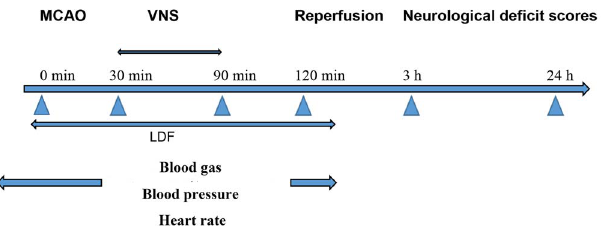
Figure 1. The Experimental Protocol. I/R and I/R + VNS groups underwent transient MCAO surgery. In the I/R + VNS and sham + VNS group, VNS was initiated at 30 min after occlusion and repeated every 5 min for 1 h. At 120 min, I/R and I/R + VNS groups underwent reperfusion. During the experiment, the mean CVA, HR, and blood gas were measured at the designated time points. Laser doppler flowmetry monitored the changes of right cerebral middle artery blood flow, and temperature was maintained at approximately 37 u C. Neurological deficit scores assessment was performed at 3 and 24 h after reperfusion.